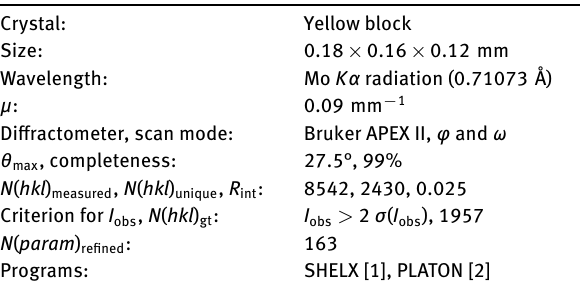
Table 1: Data collection and handling.